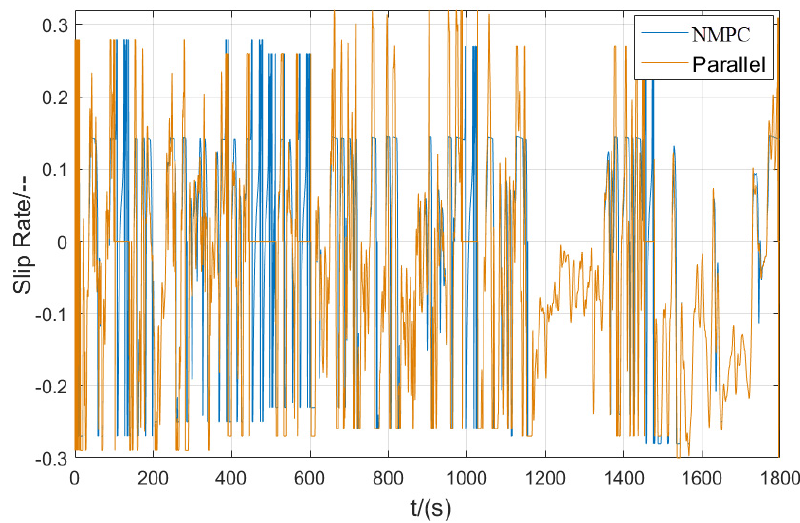
Figure 11. The slip rate curve.